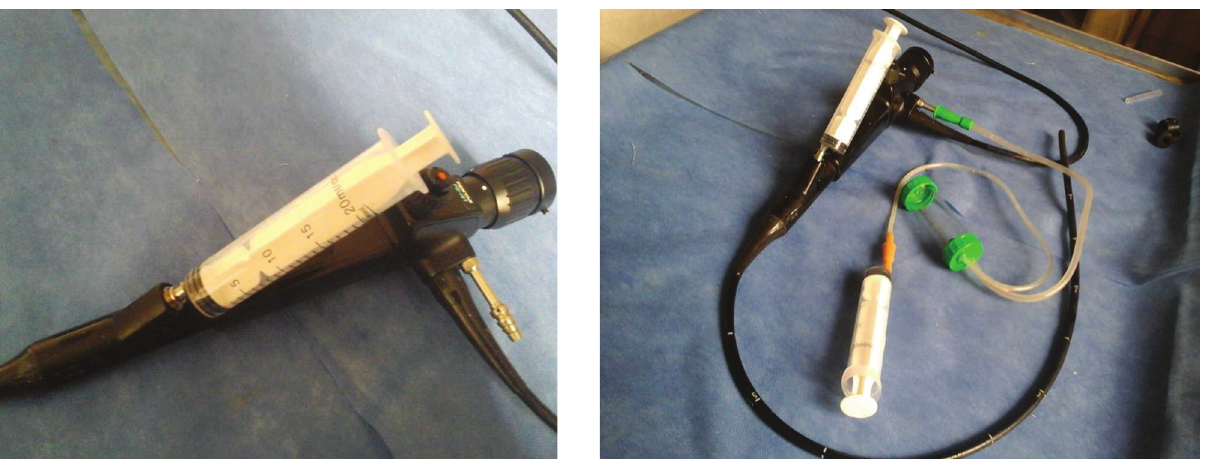
Syringe suction with trap. Group II (SST group).